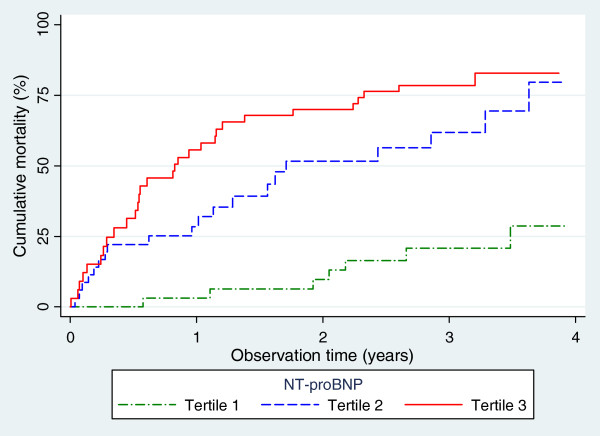
Mortality after acute exacerbation of COPD stratified by level of NT-proBNP. Based on 217 admissions and 57 mortalities in 99 patients.